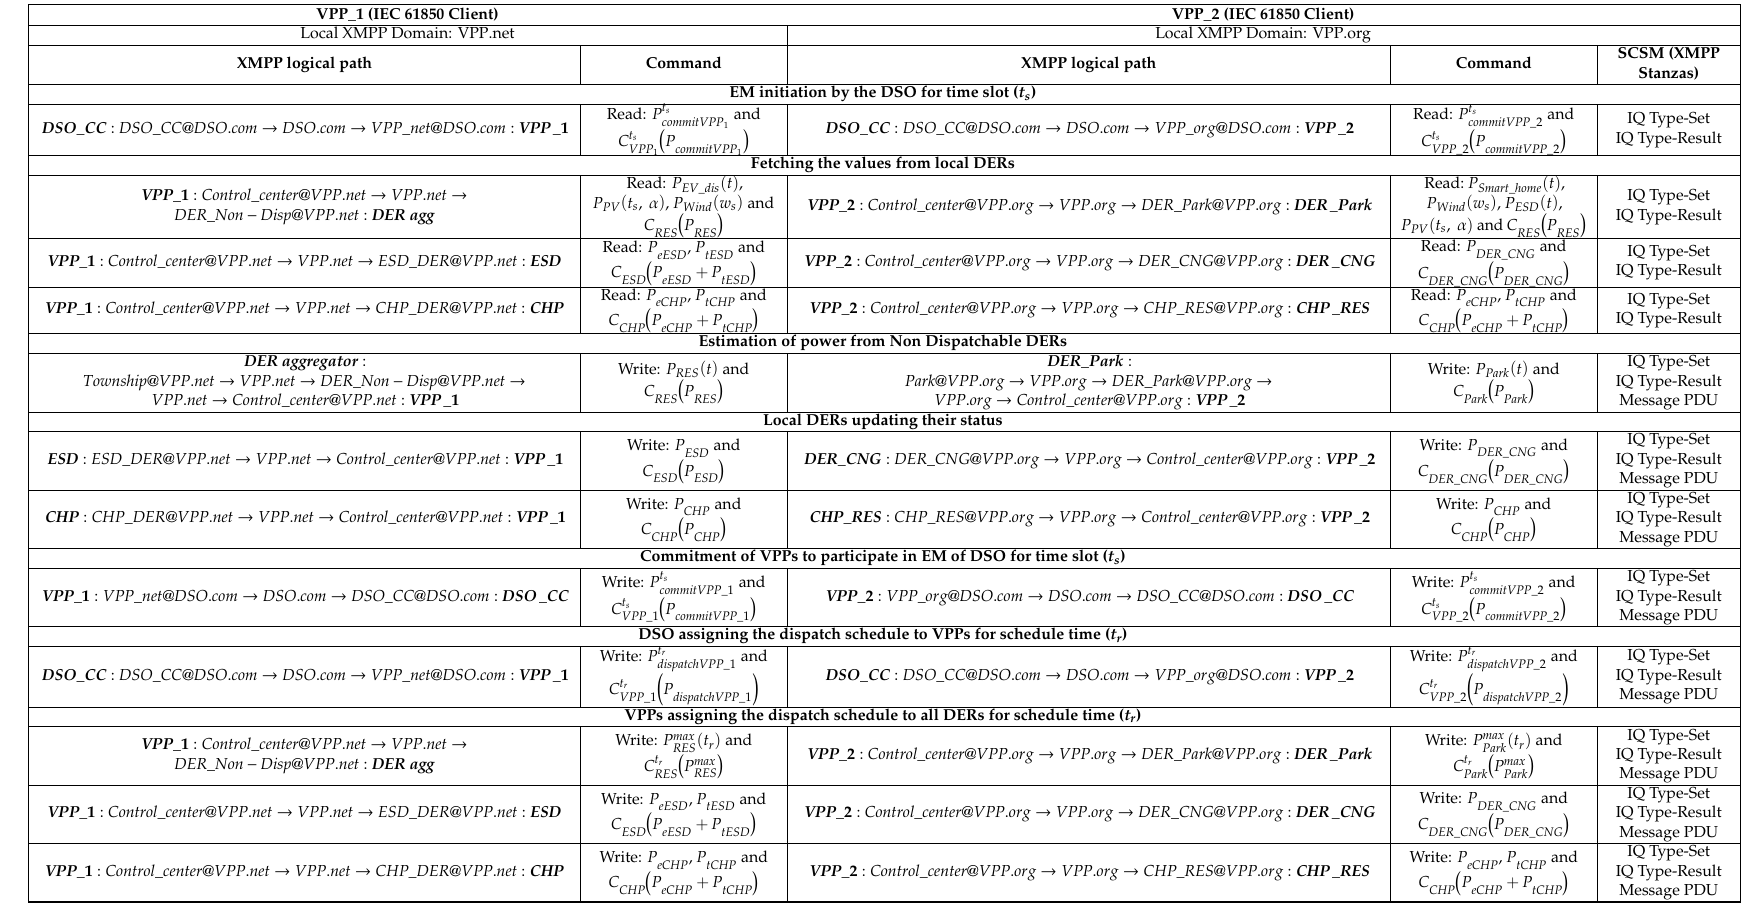
Table 2. Message Exchanges between DSO and VPPs (multiple JID